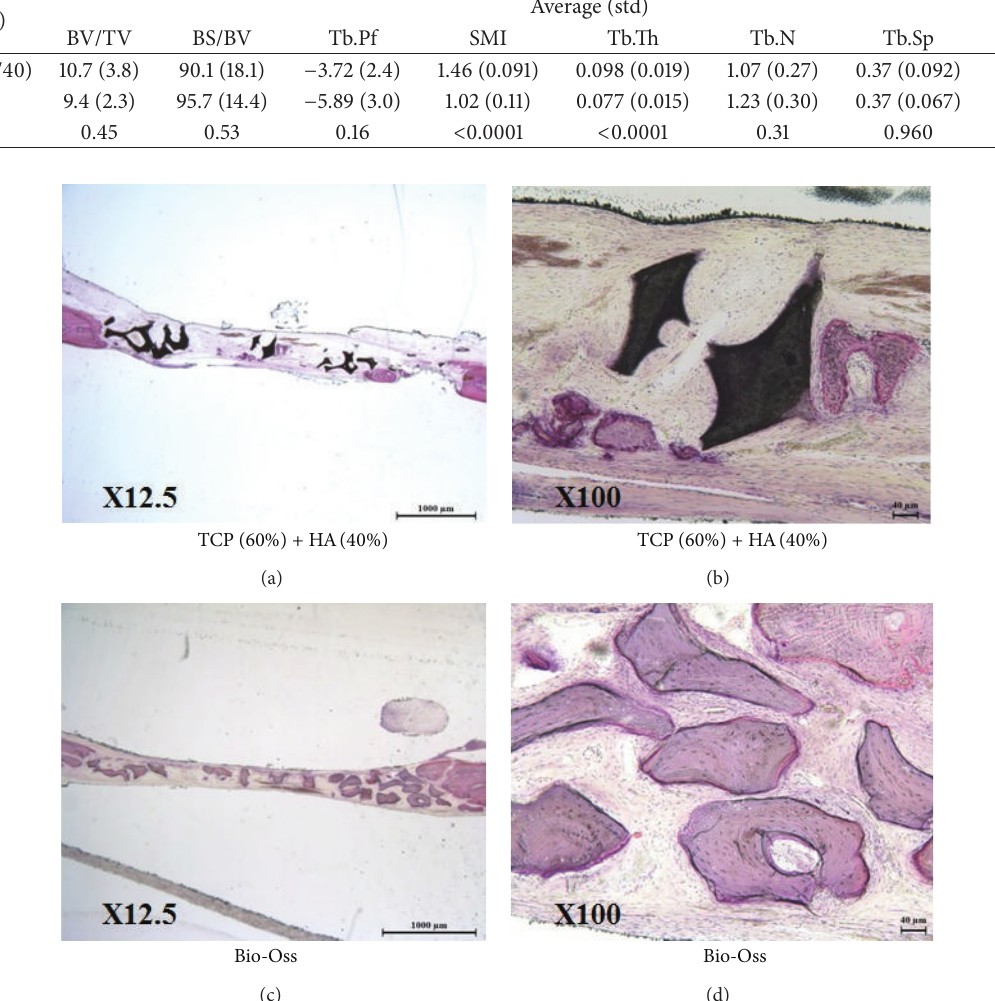
Figure 7: Undecalcified histology of 60TCP40HA and Bio-Oss 4 weeks after